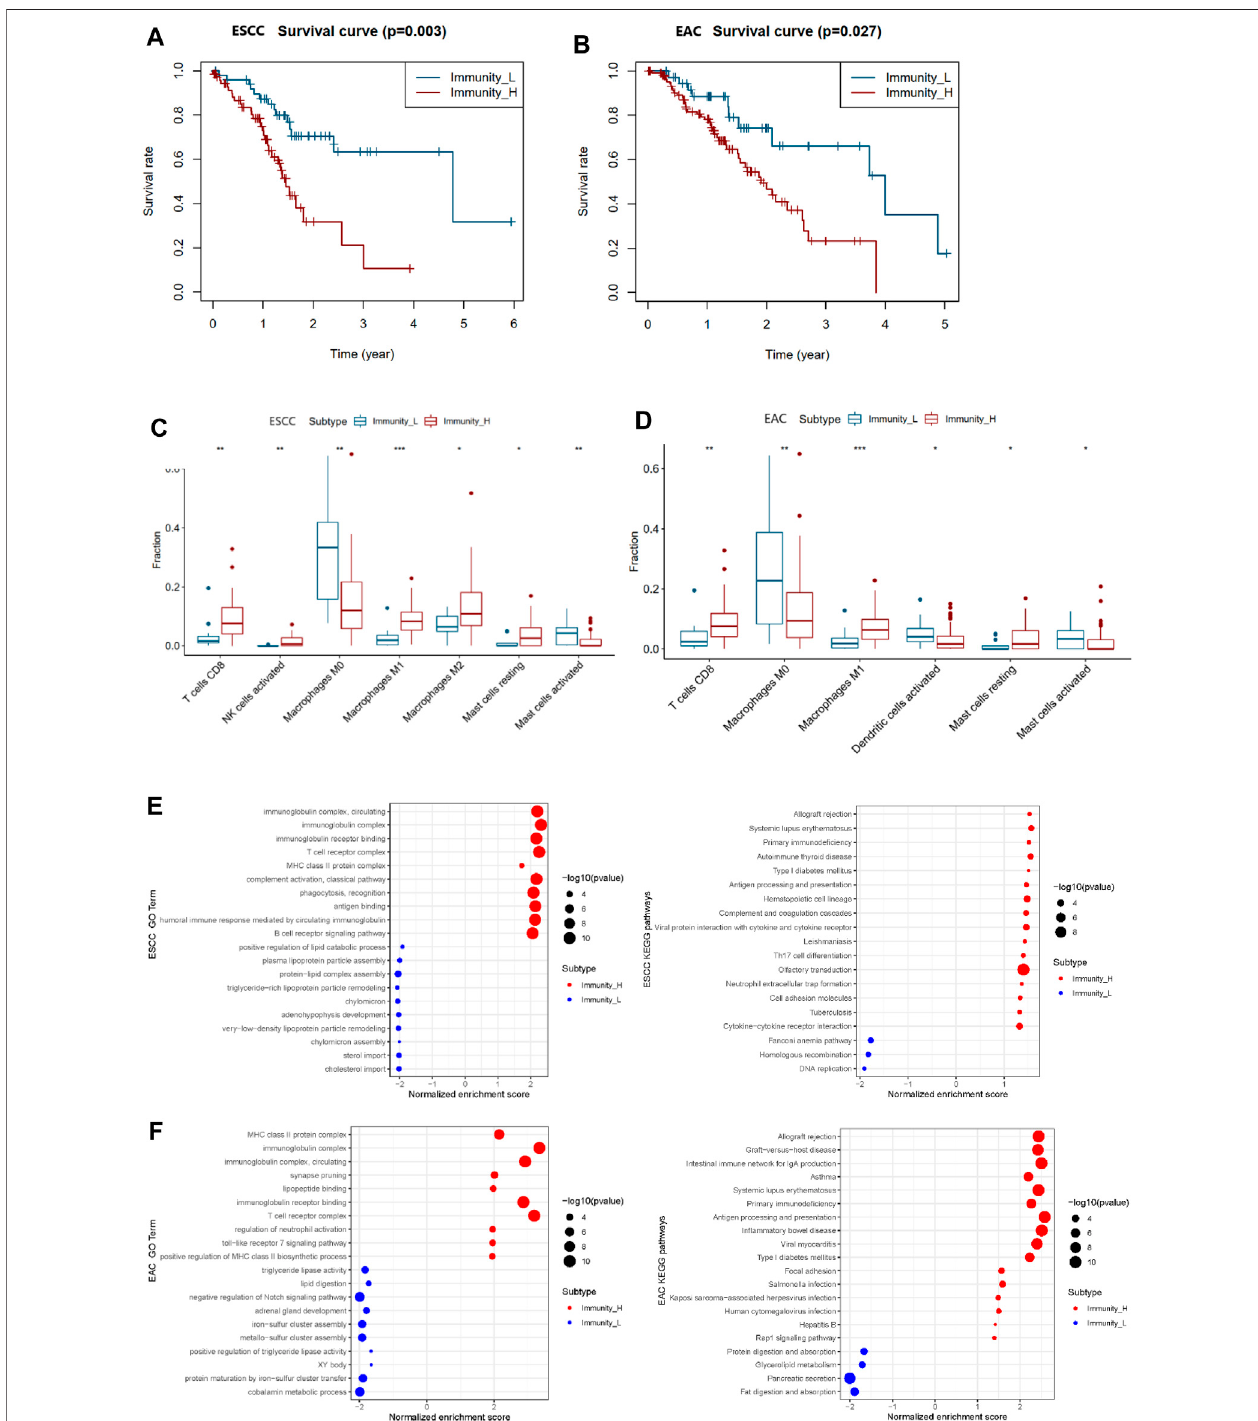
FIGURE 3 | Differential survival, TILs, and enriched functions and pathways of two immunity clusters in ESCC and EAC. (A) Survival curve of Immunity_L and Immunity_H groups in ESCC. (B) Survival curve of Immunity_L and Immunity_H groups in EAC. (C) Boxplot of differential TILs in Immunity_H and Immunity_L in ESCC. (D) Boxplot of differential TILs in Immunity_H and Immunity_L in EAC. (E) The most enriched GO terms and KEGG pathways between Immunity_L and Immunity_H groupsinESCC. (F) Themostenriched GOtermsandKEGGpathwaysbetweenImmunity_LandImmunity_HgroupsinEAC.TILs,tumor-in fi ltratinglymphocytes; GO, Gene ontology; KEGG, Kyoto Encyclopedia of Genes and Genomes. * p < 0.05; ** p < 0.01; *** p < 0.001.